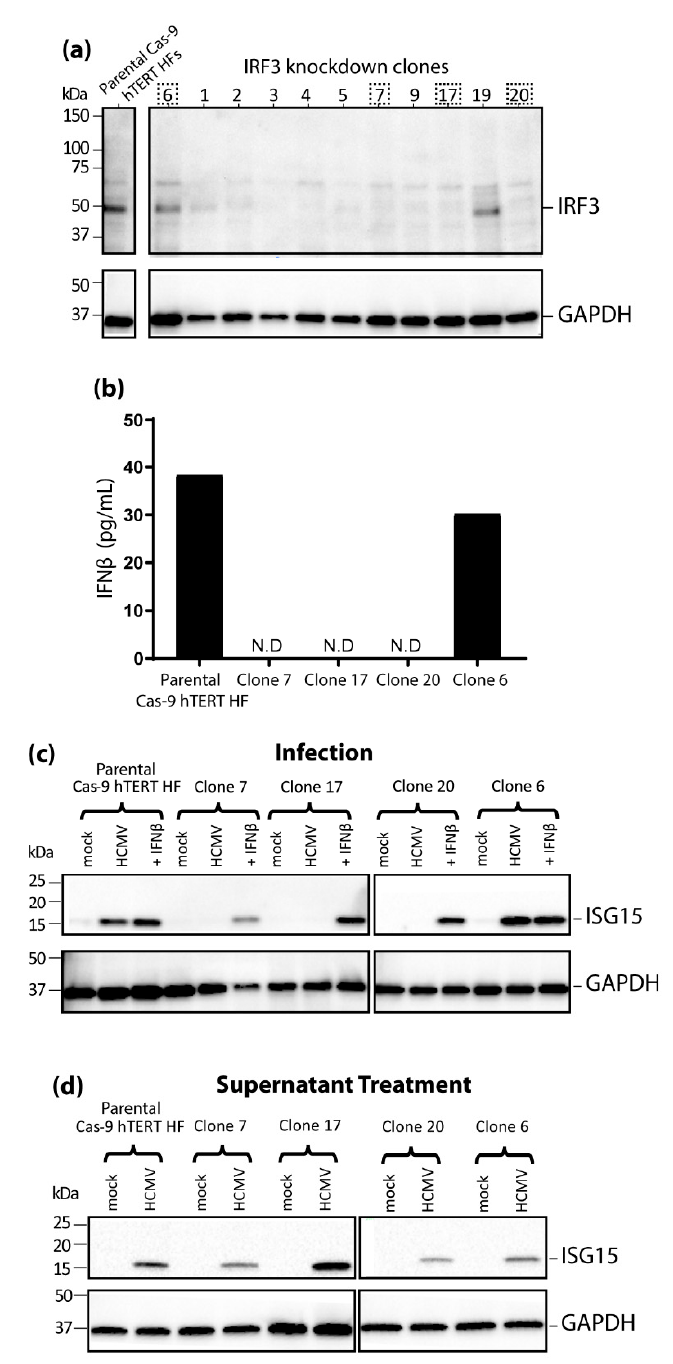
Figure 3. IFN-independent, IRF3-dependent regulation of ISG15 recapitulated in IRF3 knockout (KO) CRISPR/Cas-9 engineered telomerase immortalized (hTERT) HFs. ( a ) IRF3 KO clones generated by CRISPR/Cas-9 were screened by immunoblot for IRF3 alongside the parental Cas-9 hTERT HFs with GAPDH as a loading control. The dashed boxes denote which clones were chosen for further experiments. ( b ) Supernatants were collected from the Cas-9 hTERT HFs and individual clones after 24 h of HCMV infection (MOI 3) before IFN β was quantified by an enzyme-linked immunosorbent assay (ELISA) (N.D: not detected indicates IFN β levels less than the lower limit of quantification 5 pg/mL). ( c ) Successful IRF3 KO clones 7, 17 and 20 were infected with HCMV (MOI of 3) or treated with recombinant IFN β (100U) in parallel with unsuccessful clone 6, and the parental Cas-9 hTERT HFs. Protein lysates were extracted at 24 h.p.i. before immunoblotting for ISG15 and GAPDH . ( d ) Individual clones and parental Cas-9 hTERT HFs were treated with supernatant from HCMV infected cells for 24 h before immunoblotting for ISG15 and GAPDH